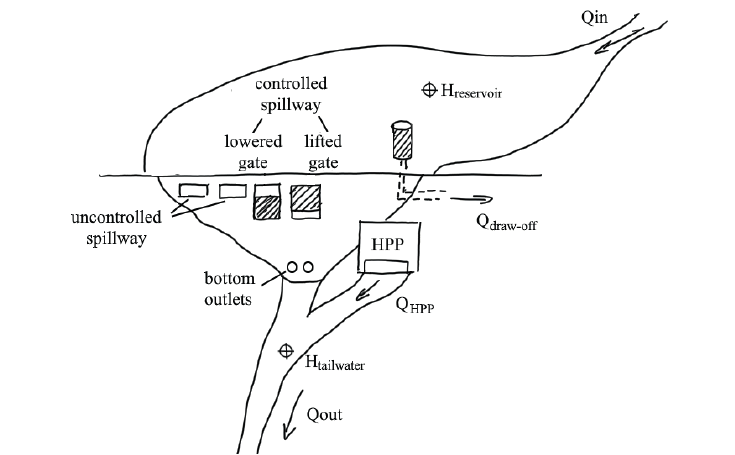
Fig. 1. Dam discharge objects